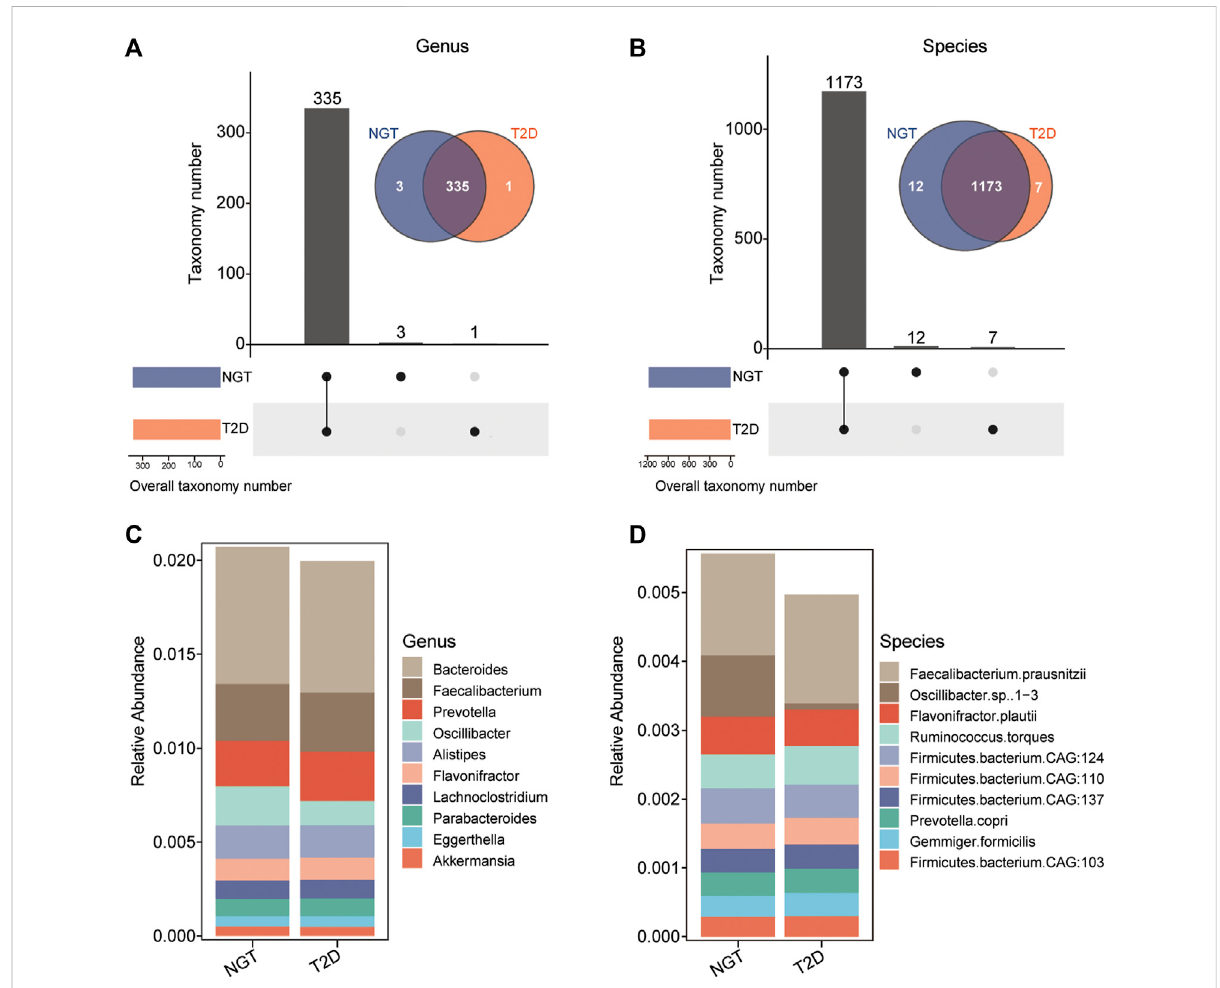
FIGURE 4 Taxonomic identi fi cation and the distribution of bacteria harboring LPS-biosynthesis-related enzymatic genes in individuals with NGT and patients with T2D. (A,B) UpSet plot and Venn diagram showing the distribution of bacteria harboring LPS-biosynthesis-related enzymatic genes, shared and unique in the NGT and T2D groups at the genus, and species levels, respectively. Bar charts above represent the number of genera, and species harboring LPS-biosynthesis-related enzymatic genes, shared and speci fi c between groups. At the bottom left, bar charts indicate the bacteria that harbored LPS-biosynthesis-related enzymatic genes in each group (orange, T2D; blue, NGT). The line between nodes at the bottom right denotes the intersected taxon within each group. (C,D) Stack columns depicting the relative abundance for the top 10 genera and species with LPS-producing potentials (enzymatic genes) in NGT and T2D. T2D, type 2 diabetes; NGT, normal glucose